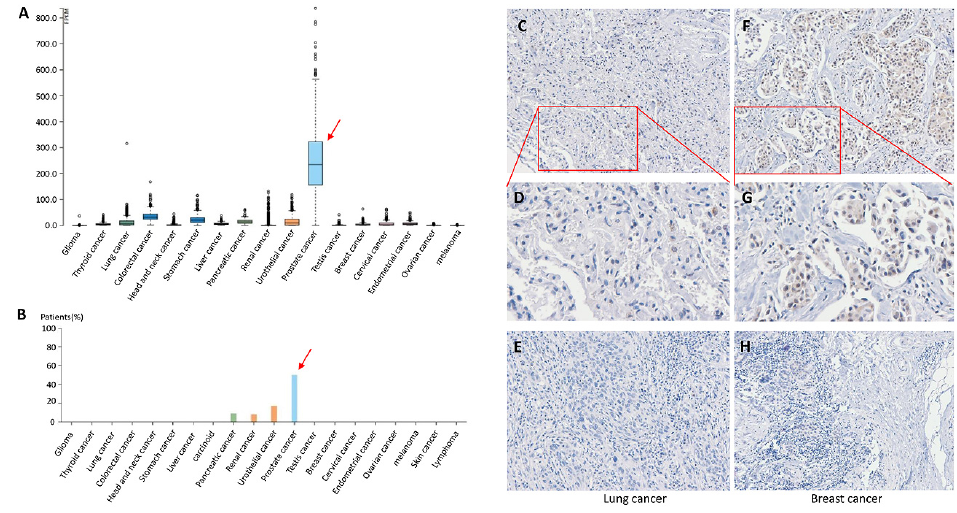
Figure 1. TMPRSS2 expression in pan-cancers. ( A ) TMPRSS2 mRNA expression in pan-cancers. ( B ) TMPRSS2 protein expression in pan-cancers. ( C , D ) IHC of TMPRSS2 in lung cancer tissues. ( E ) IHC of TMPRSS2 in lung cancer tissues. ( F , G ) IHC of TMPRSS2 in breast cancer tissues. ( H ) IHC of TMPRSS2 in breast cancer tissues. ( D , G ) Enlarged images of ( C , F ), respectively.